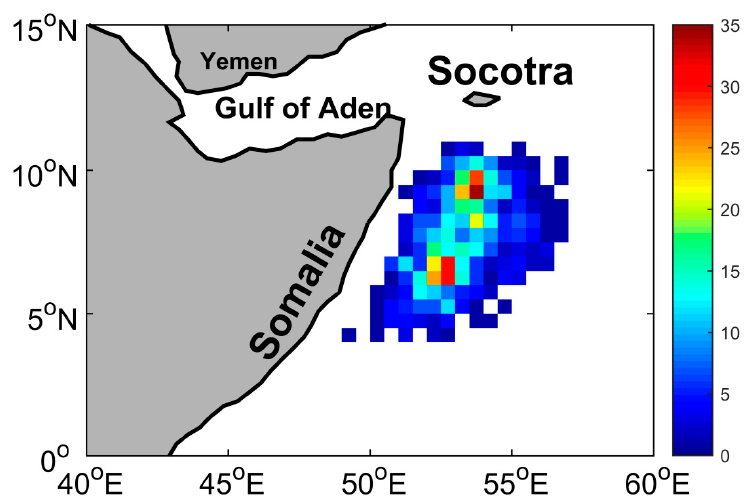
Figure 8. The number of the GW centers presented in bins 0.5 ◦ × 0.5 ◦ from 1993 to 2015 (background color is the numbers.